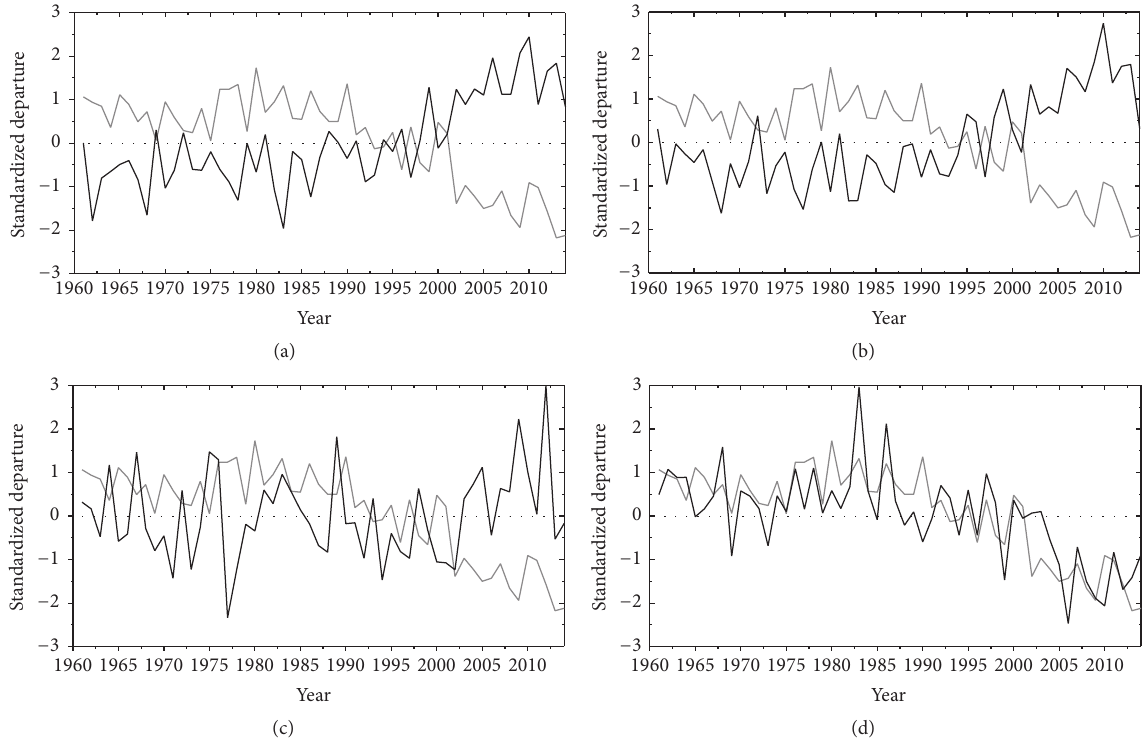
Figure 7: Time series of annual air temperature (a), thawing index (b), annual precipitation (c), and freeze depth (d) in TRSR (black line) with the time series of freeze last date (grey line). All variables were standardized with respect to their mean and standard deviation.